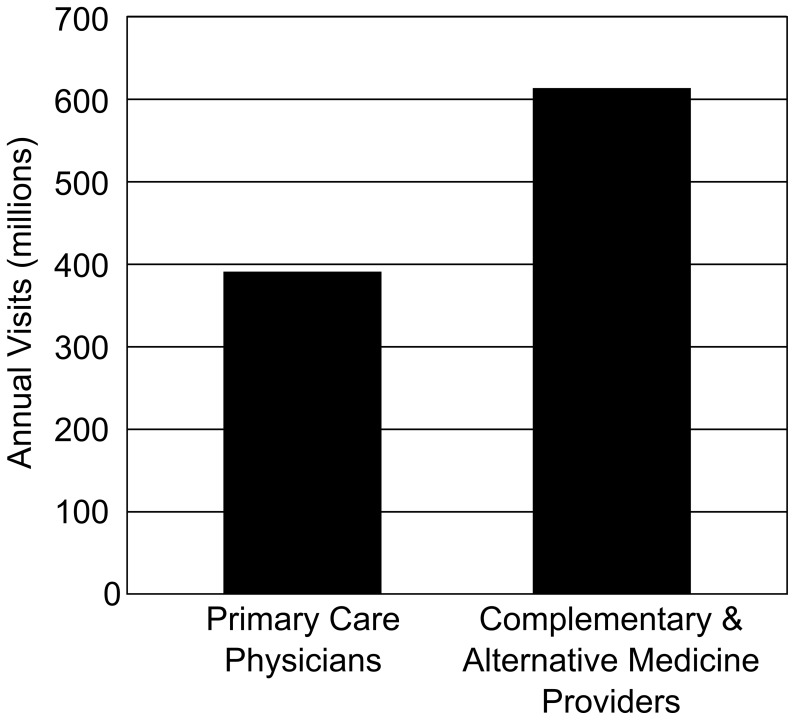
Use of Alternative medicine in relation to Conventional Medicine [34].